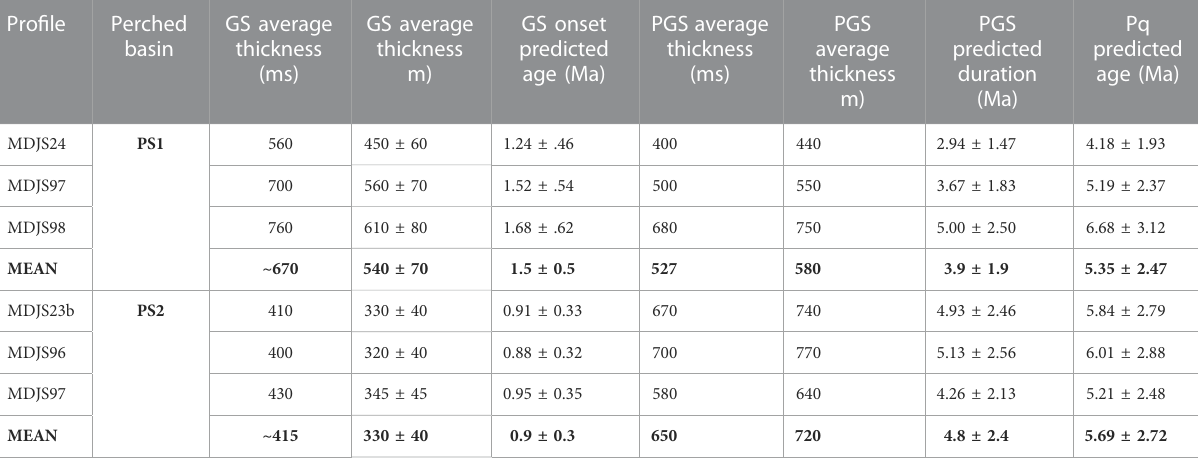
TABLE 1 Thickness of growth strata (GS) and age estimates for the GS onset in perched basins identi fi ed off Boumerdès (Figures 8, 9) assuming an interval seismic velocity of 1.6 ± 0.2 km/s and a constant sedimentation rate of 0.4 ± 0.1 mm/yr during Quaternary times. A predicted age of the Plio-Quaternary (PQ) unit is also computed using a constant sedimentation rate of 0.2 ± 0.1 mm/yr during Pliocene times (Martinez-Garcia et al., 2013). Pre-growth strata (PGS) thickness is computed assuming an average seismic velocity of 2.2 km/s. Values of average thicknesses of GS and PGS units are taken from Figure 8; Figure 9 (double black and blue arrows, respectively).